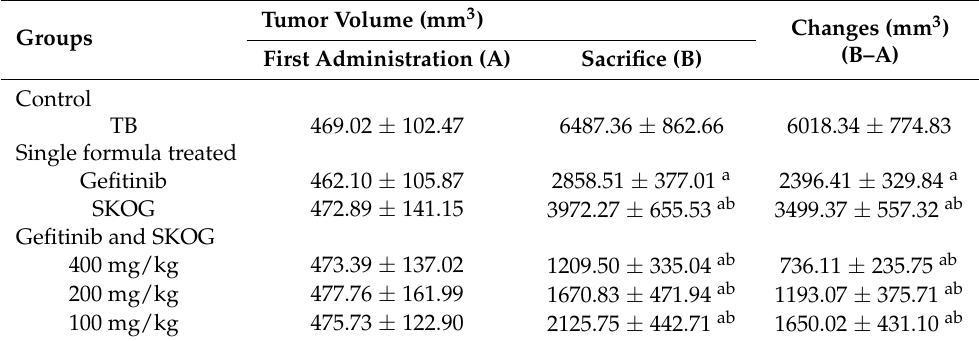
Table 2. Changes in the tumor volume in NCI-H520 tumor cell xenograft mice.